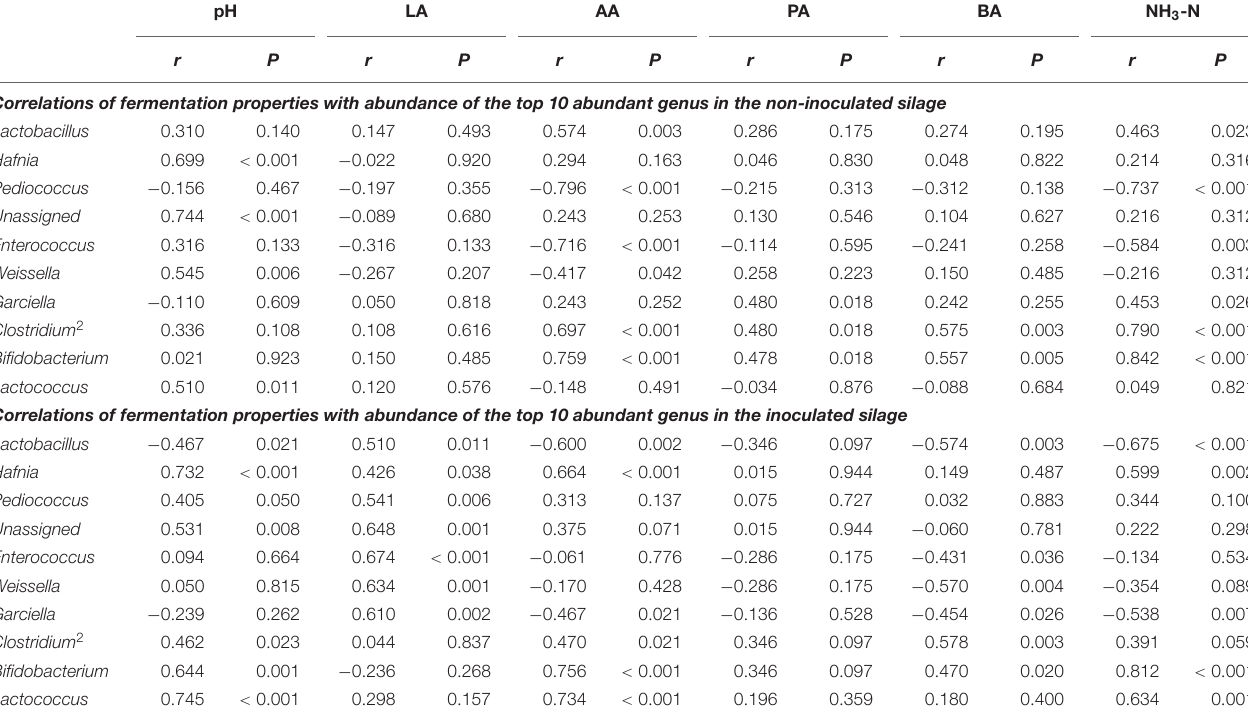
TABLE 2 | Spearman’s correlation analyses of fermentation properties with abundance of the top 10 most abundant genera in the non-inoculated and inoculated silage 1